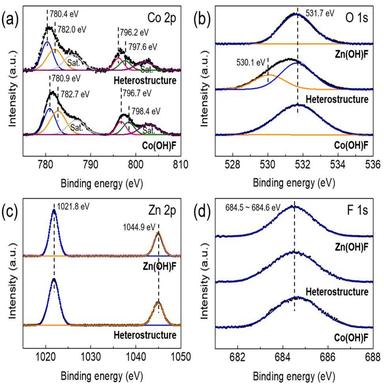
XPS spectra of the Co(OH)F microflowers, Zn(OH)F nanorods, and the heterostructures (3:1) ((a) Co 2p, (b) O 1s, (c) Zn 2p, and (d) F 1s).